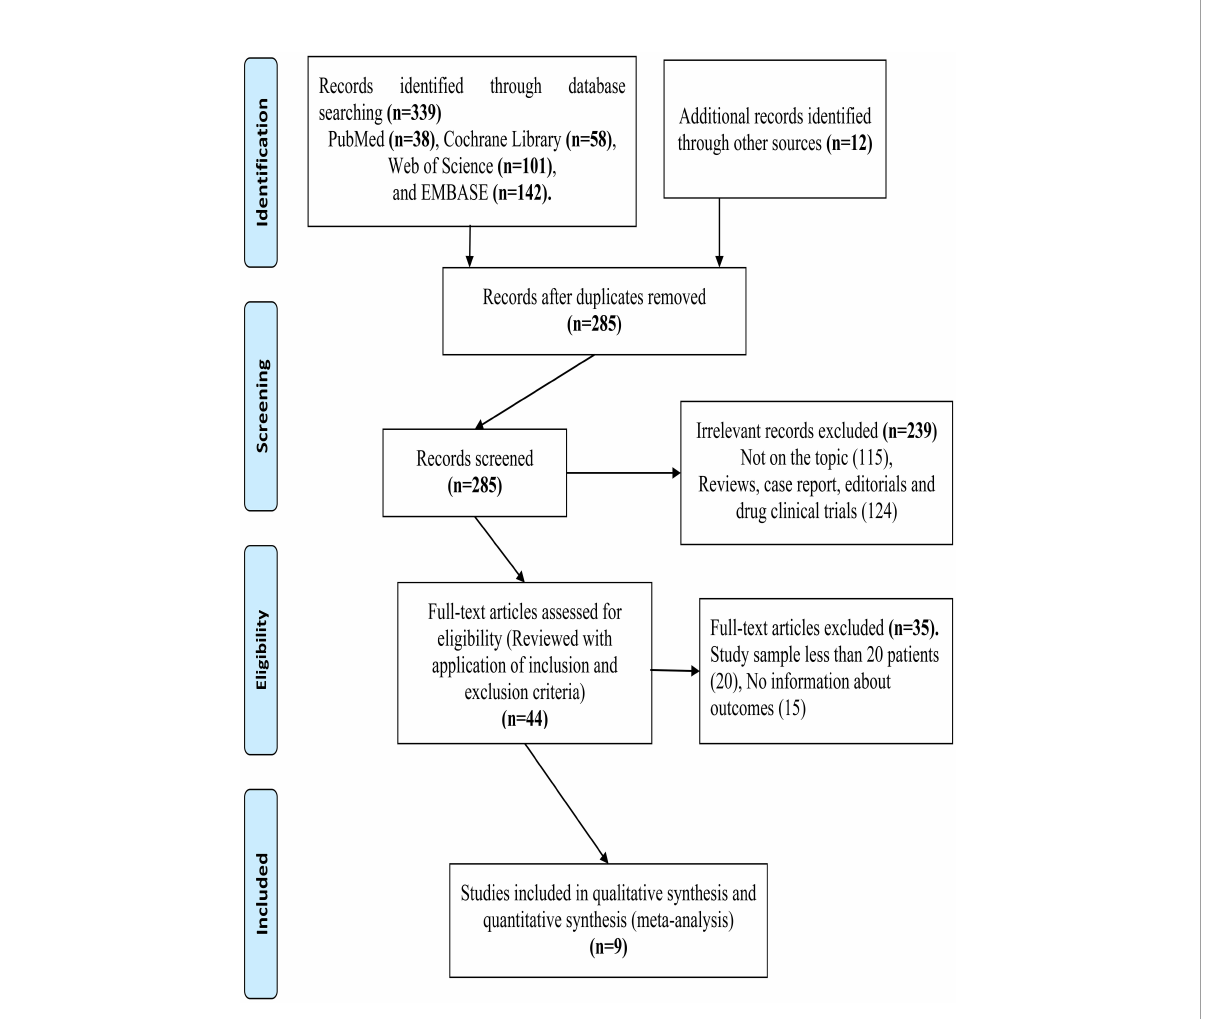
FIGURE 1 PRISMA fl ow chart of the the data